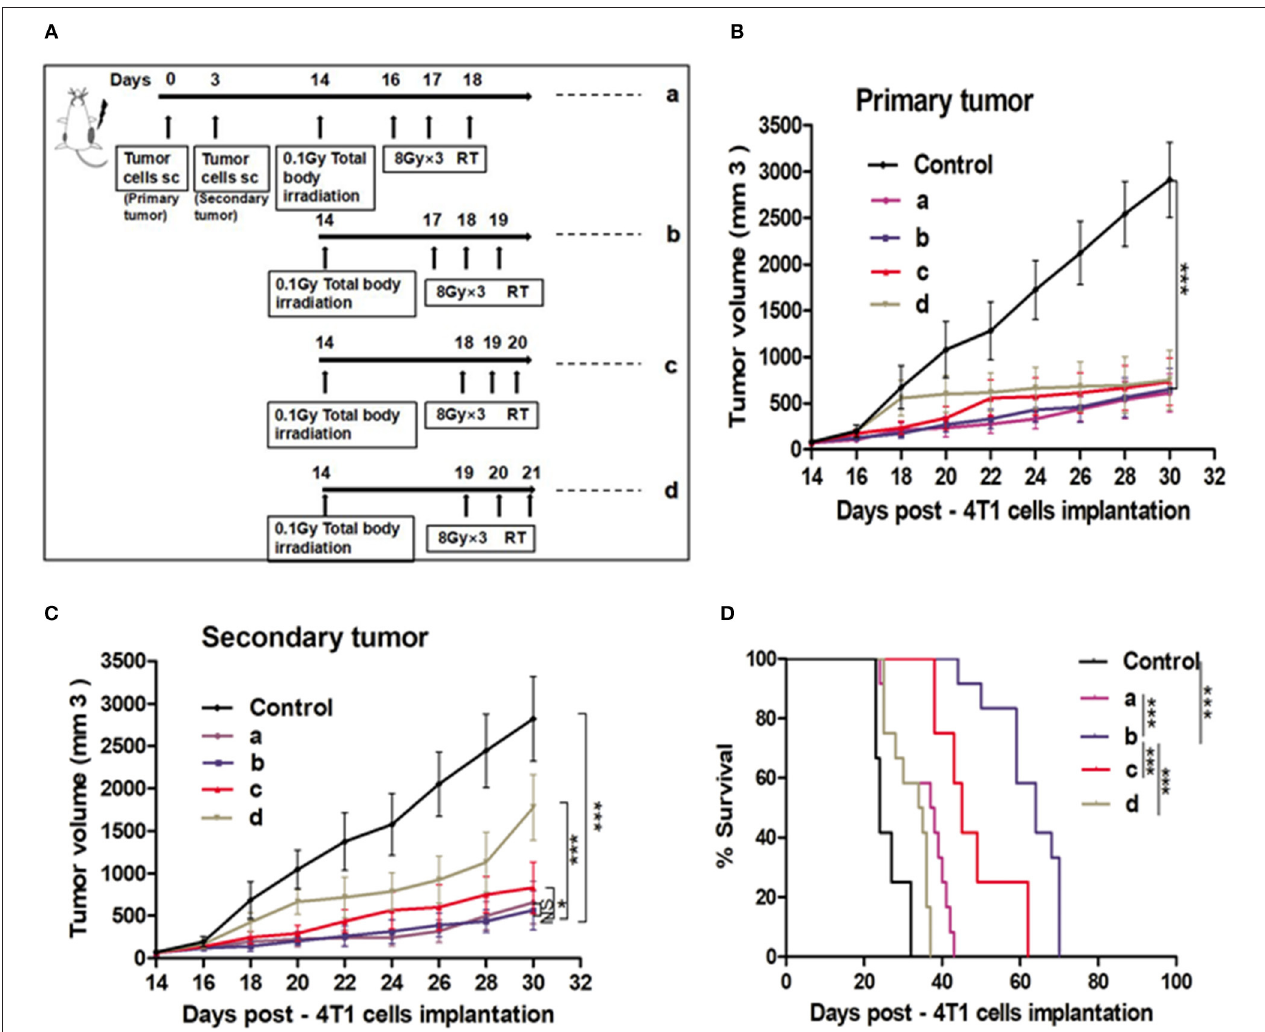
FIGURE 2 | Effect of different time intervals of the H-RT and L-TBI combination therapy in 4T1 tumor-bearing mice. (A) Treatment timeline of the 4T1 mammary carcinoma BALB/C mouse model. Tumor growth of primary tumors (B) and secondary tumors (C) in different experimental groups. (D) Overall survival curves of the treatment groups. Immunocompetent mice were injected s.c. with syngeneic 4T1 cells (1 × 10 5 ) into the right (primary tumor) and left (secondary tumor), respectively. The 12 mice/group irradiated with H-RT (8Gy x 3) at 48h (a), 72h (b), 96h (c), and 120h (d) after L-TBI. Primary and secondary tumor volumes were measured. Data are expressed as mean ± SE (* P < 0.05, *** P < 0.001 , and NS = not